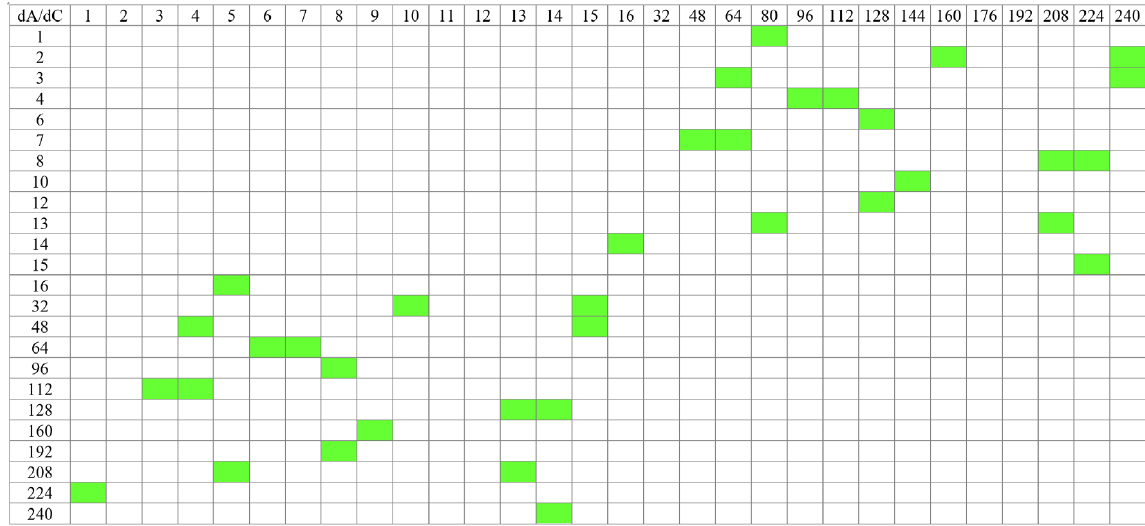
Figure 3. A fragment of the table with the results of the analysis for box S 00 .